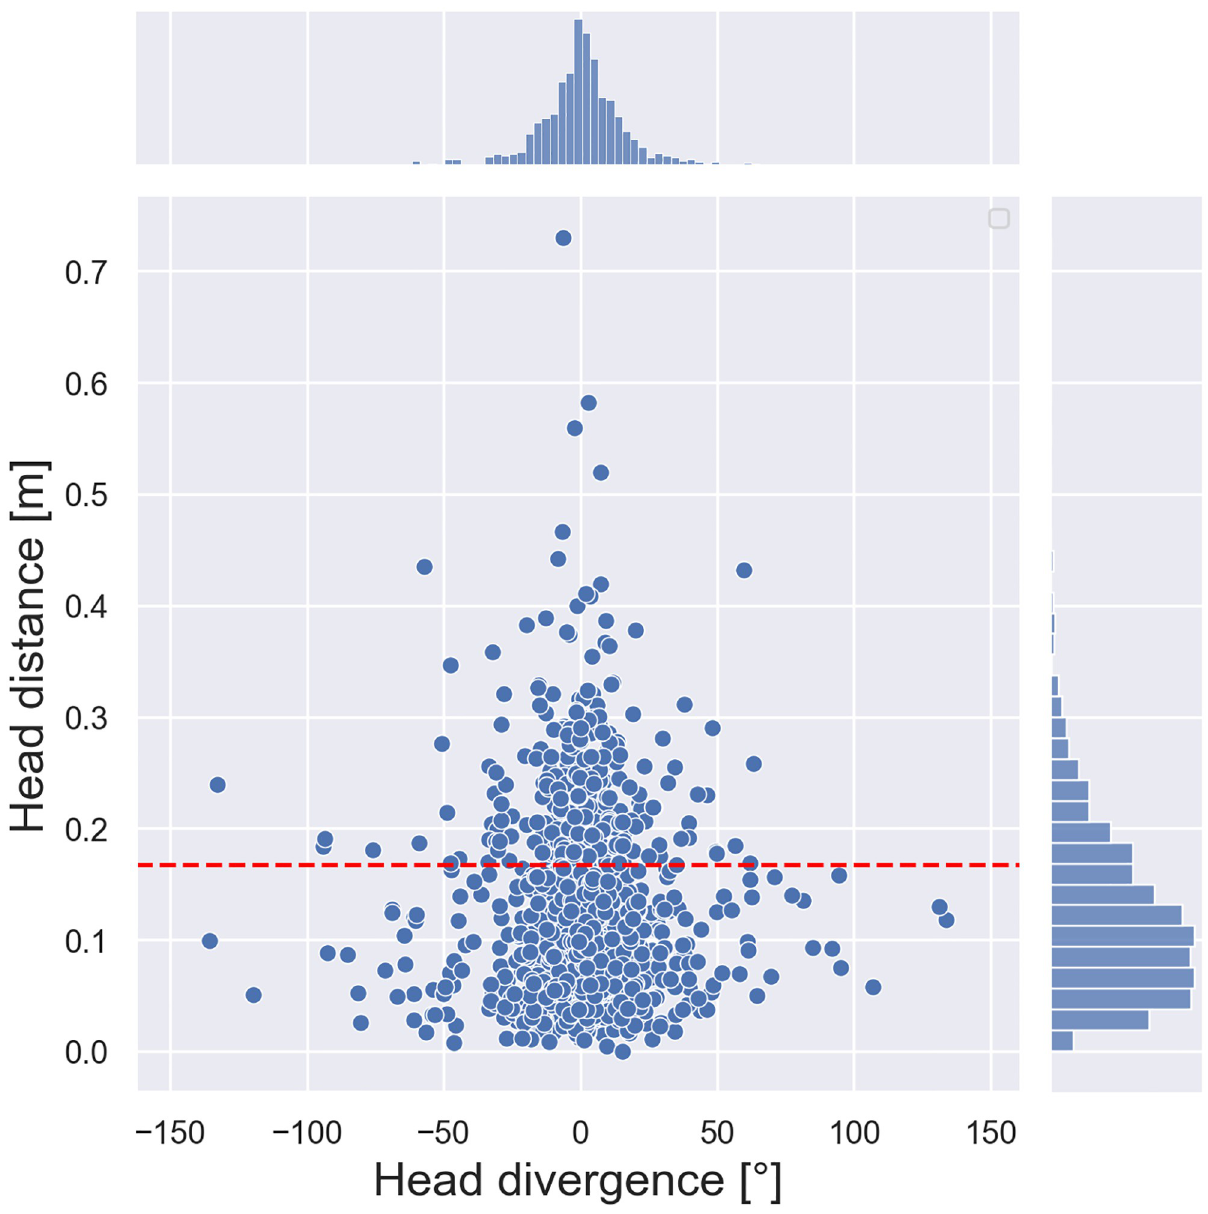
Fig 8. Head distance as a mapping of the difference between the target and head orientation angle during the hit, for group G ( V ) in condition V. The dashed red line represents the third quartile of the head distance, approximately 0.167 m. Each dot respectively indicates the outcome from a trial.